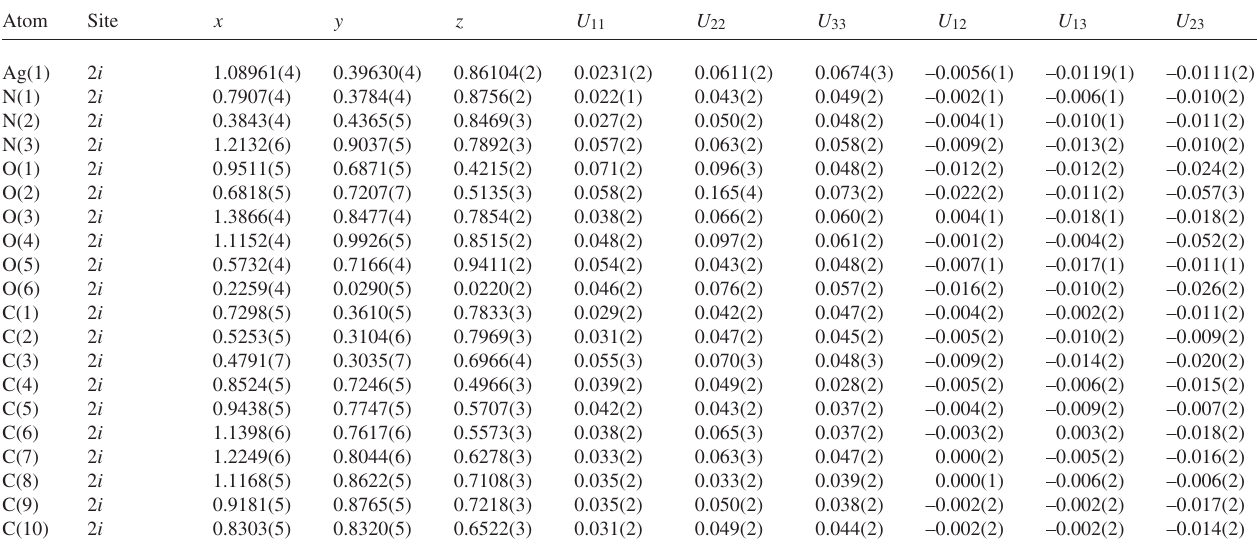
Table 3. Atomic coordinates and displacement parameters (in Å 2 )